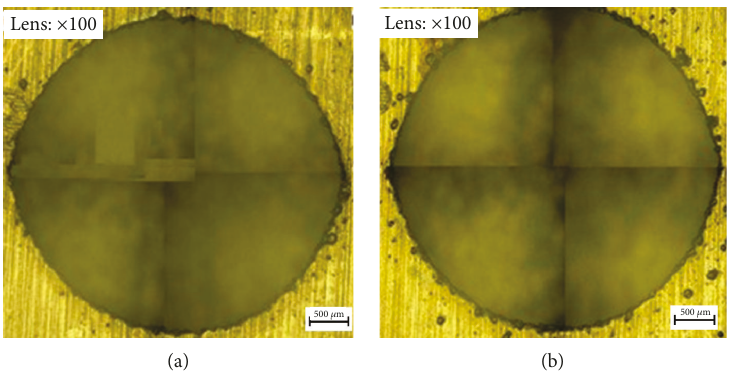
Figure 4: Comparing photos ( D = 0 8 ms (a) and D = 0 9ms (b)). Table 6: Comparison form of slag